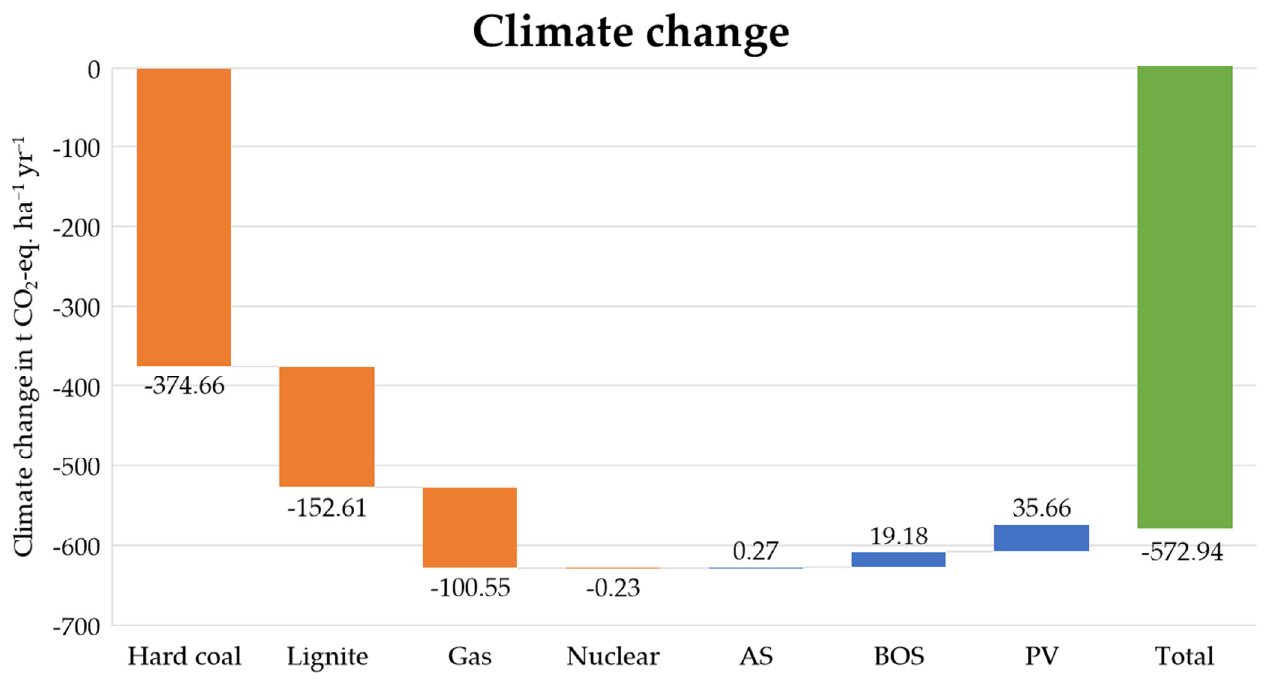
Figure 3. Environmental impact of the change of 1 ha single-use agriculture to an overhead AVS in Germany in the category climate change per year (AS: agricultural system, BOS: balance of system, PV: PV modules).